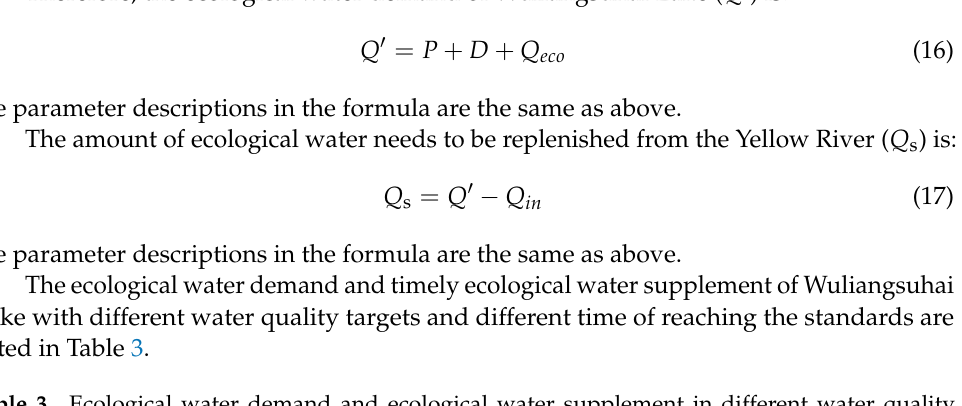
Table 3. Ecological water demand and ecological water supplement in different water quality